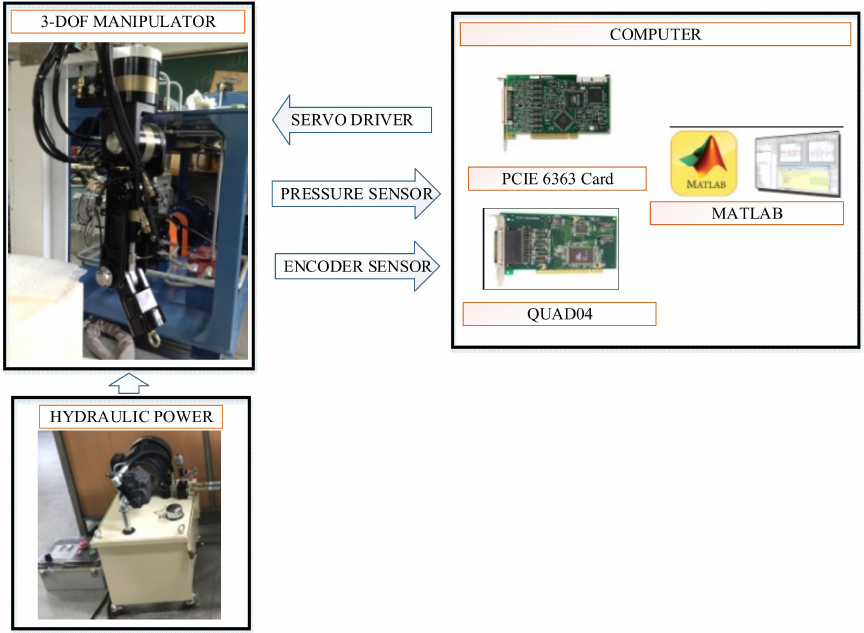
Figure 9. Structure of the test